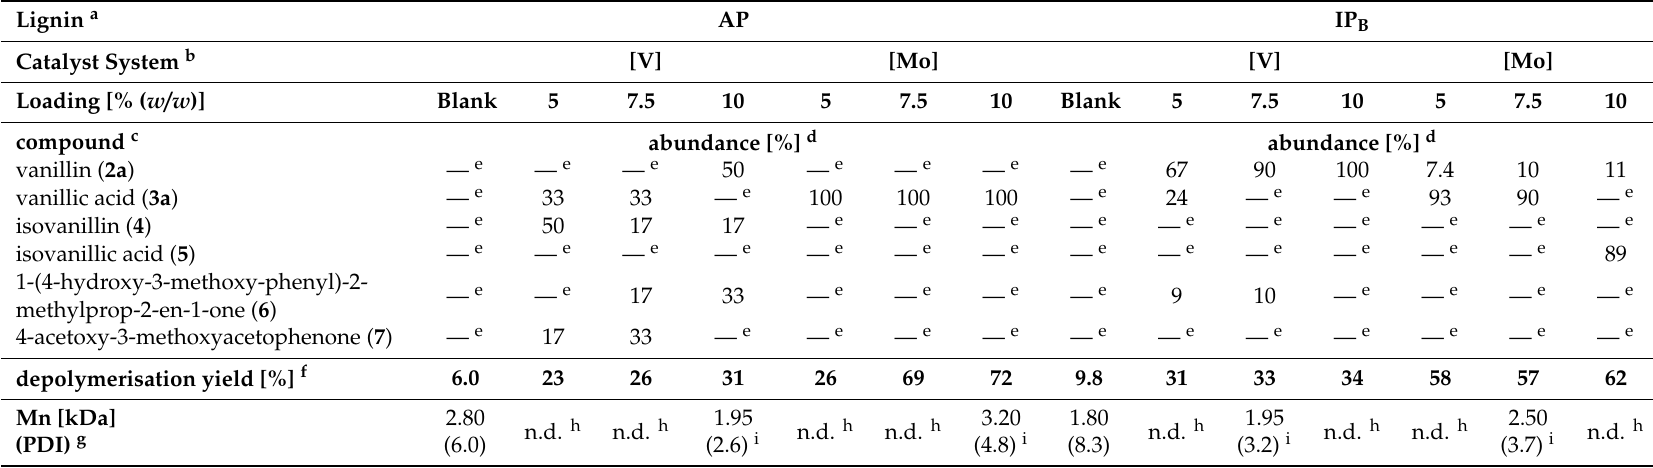
Table 2. Results obtained in the oxidative degradation of aceto- and ionosolv pine lignins, AP and IP , respectively, using various loadings of vanadate- and molybdate catalyst systems. Lignin a